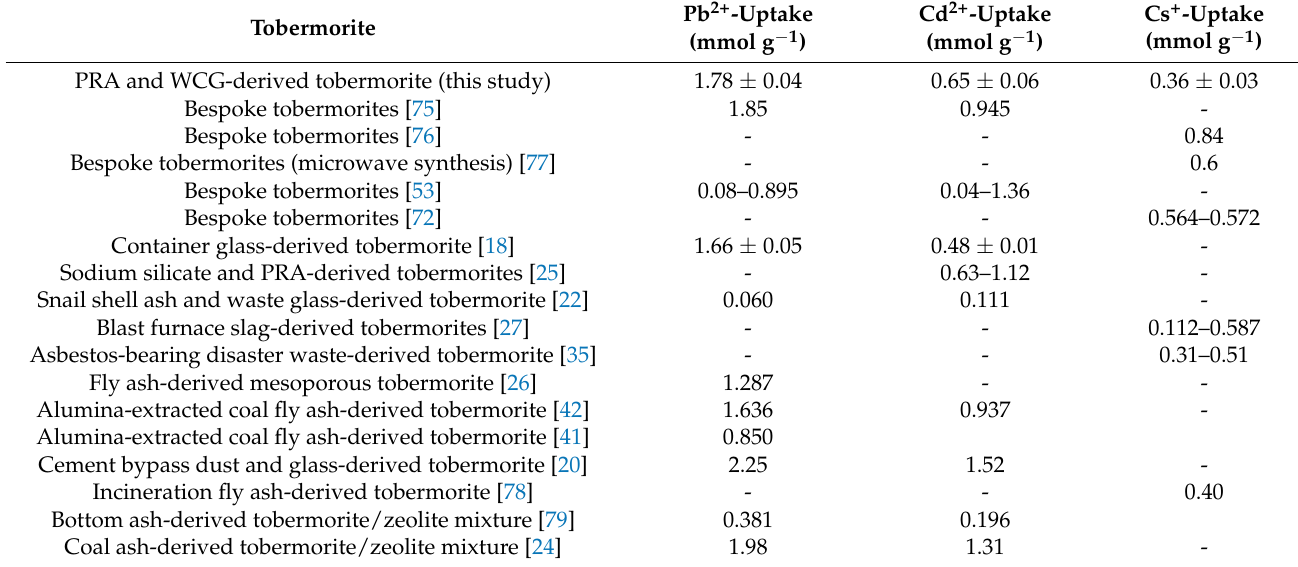
Table 6. Uptake of Pb 2+ , Cd 2+ , and Cs + ions by various tobermorites under batch